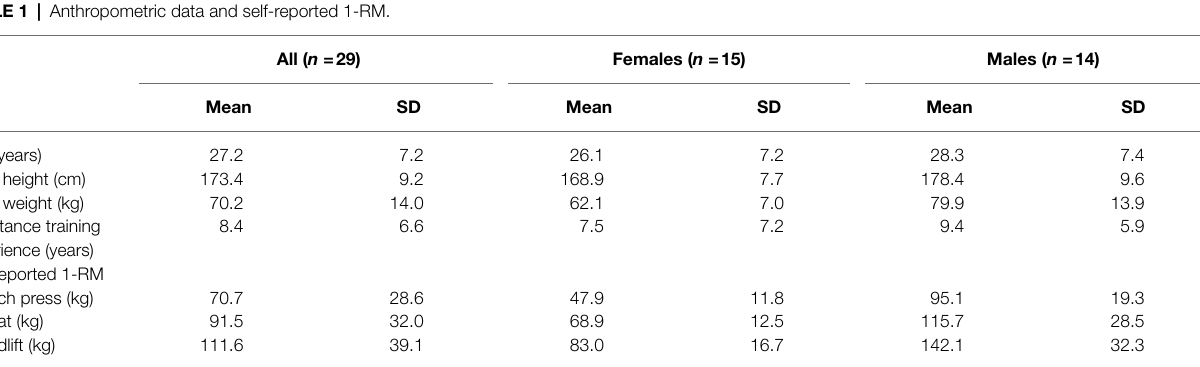
RM, repetition maximum, SD, standard